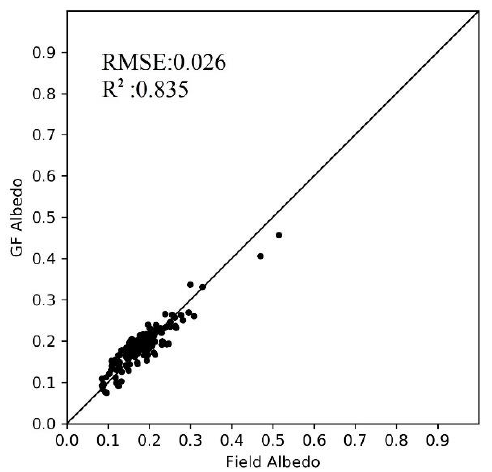
Figure 3. Comparison of GF-1 WFV estimated albedo with ground measurements.